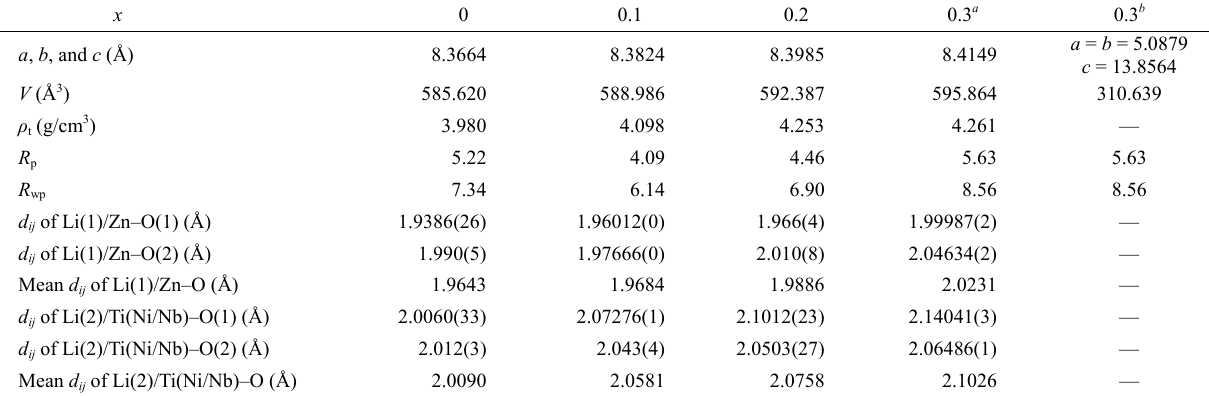
Fig. 2 Rietveld refinement patterns of LZTNN x ceramics: (a) x = 0, (b) x = 0.1, (c) x = 0.2, and (d) x = 0.3 and (e) crystal structure of LZTNN0.2 ceramics wherein Y obs is the experimental value of the plot, Y cal is the calculated value of the plot, and Y dif is the difference of intensity. Table 1 Rietveld refinement results of LZTNN x ceramics with different x